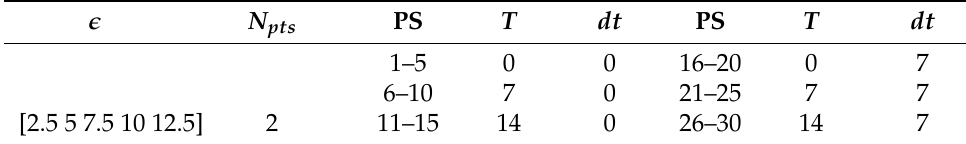
Table A2. The 30 different parameter sets used for the detection of the